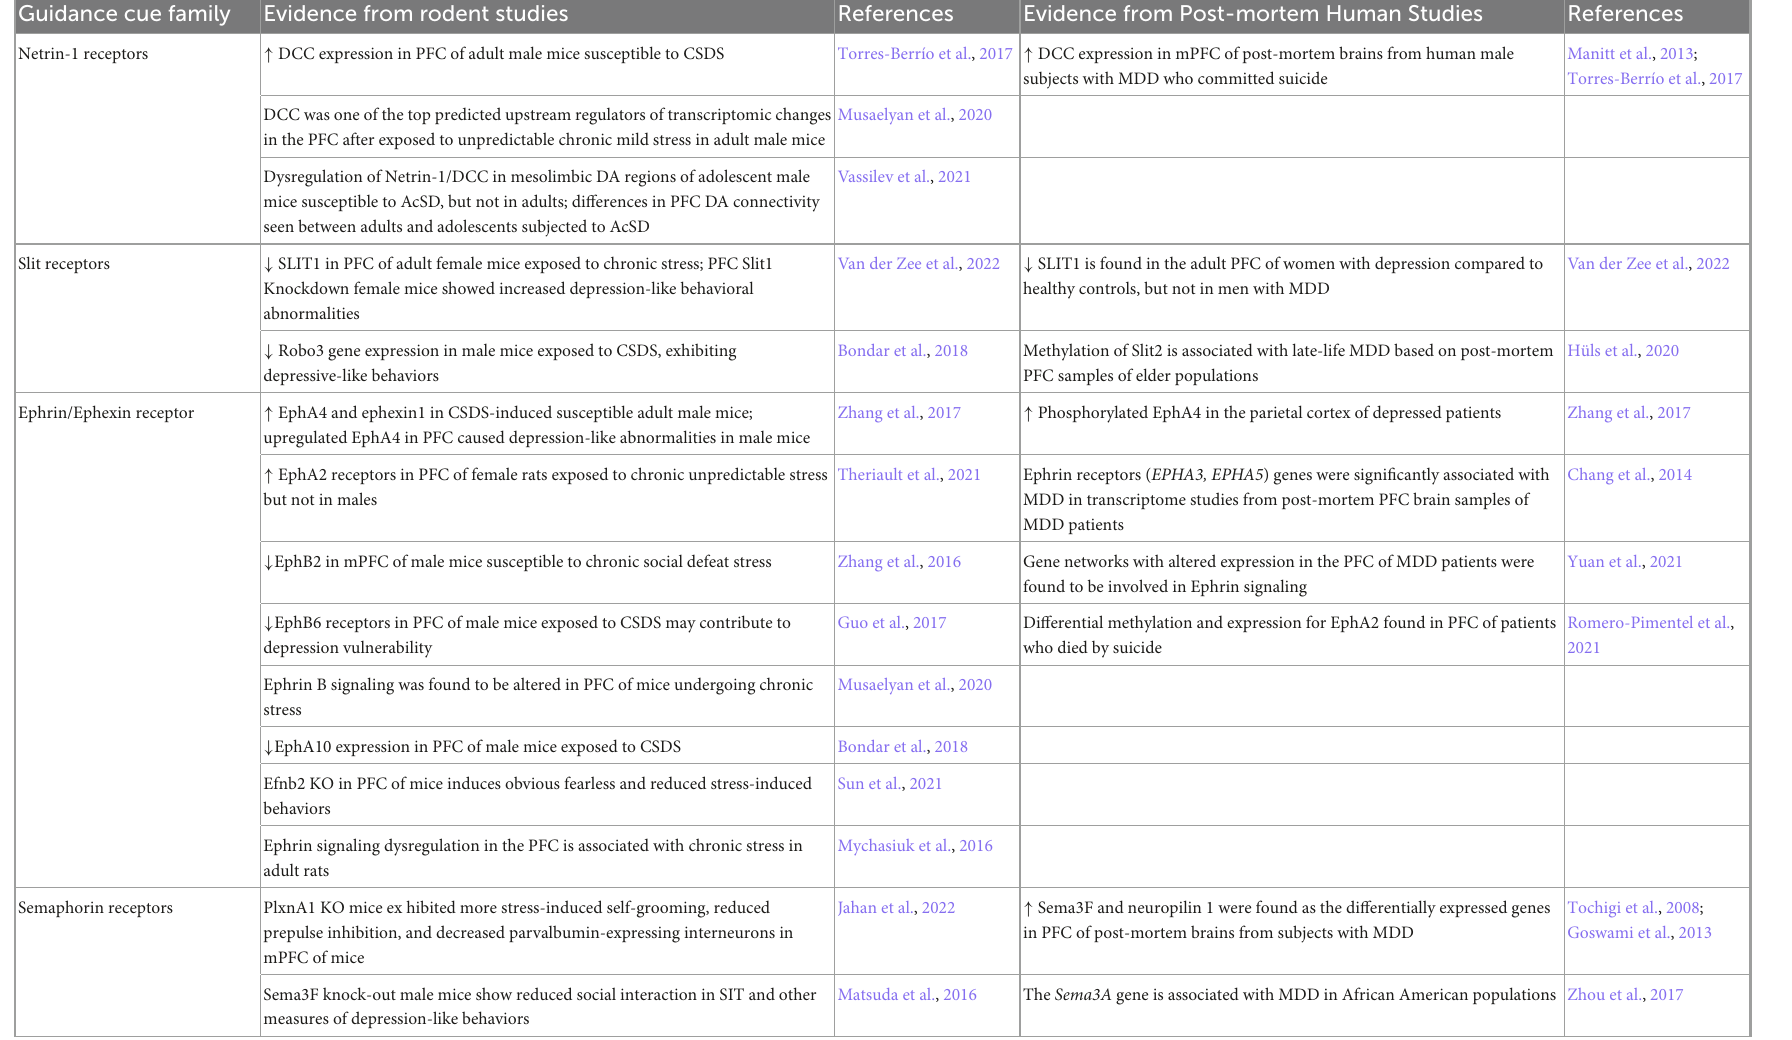
TABLE 1 Preclinical and human studies linking guidance cues to chronic stress-induced PFC reorganization and MDD (findings from rodent and human studies do not necessarily match). Guidance cue